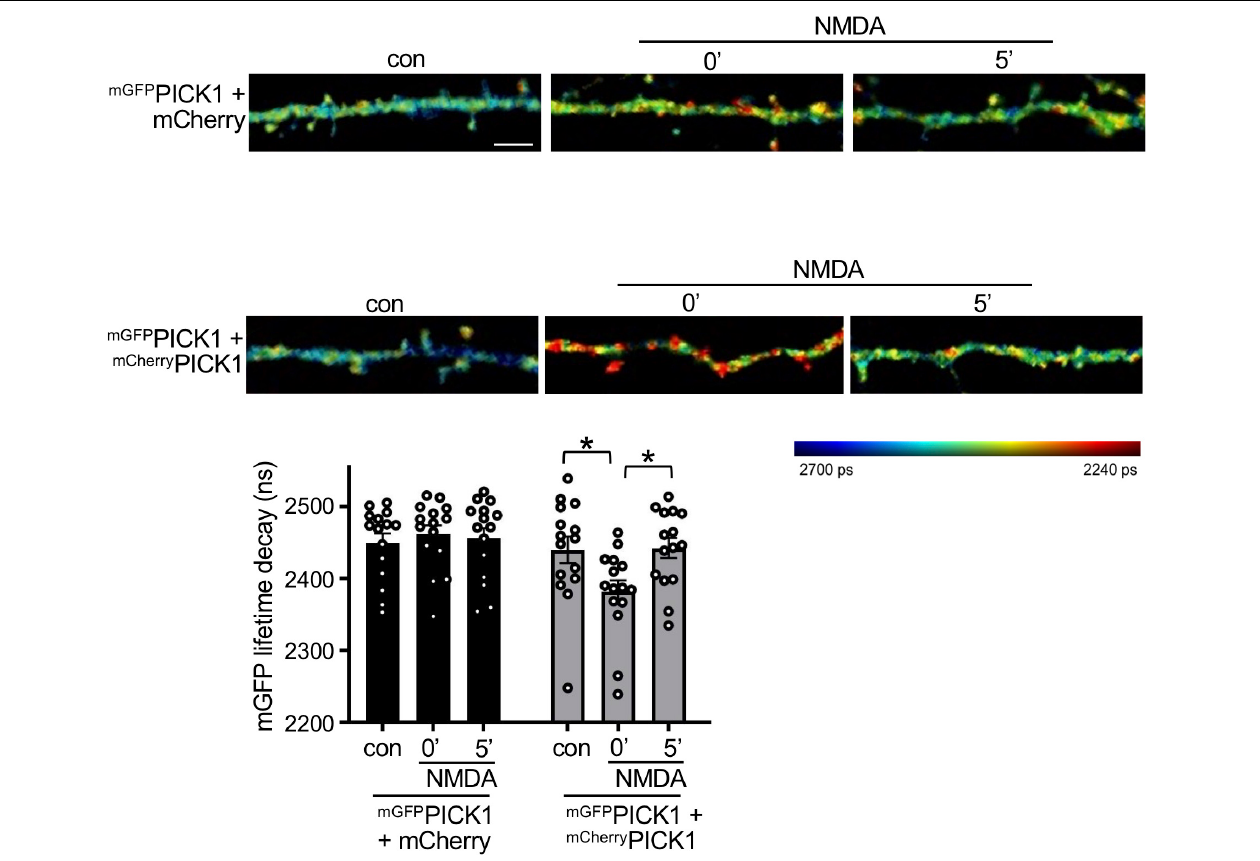
FIGURE 4 | NMDAR stimulation increases PICK1 dimerization in neurons. DIV17-18 neurons expressing mGFP PICK1 alone, mGFP PICK1 and free mCherry, or mGFP PICK1 and mCherry PICK1 were stimulated with 30 µ M NMDA or vehicle for 3 min, followed by fixation immediately after stimulation or 5 min after removal of NMDA. The lifetime decay of GFP was fitted (see the “Materials and methods” section) and the representative intensity merged, fluorescence lifetime images of neuronal dendrites are shown. Red color corresponds to short lifetime, therefore high FRET and increased PICK1 dimerization. The colored bar on the right-hand side represents the lifetime of mGFP ranging from 2,240 ps (red) to 2,700 ps (blue). The lifetime signal is intensity-adjusted and the scale bar is consistent between panels at 5 µ m. The graph shows mean recorded lifetimes; n = 15 cells from five independent experiments, * p < 0.05, one-way